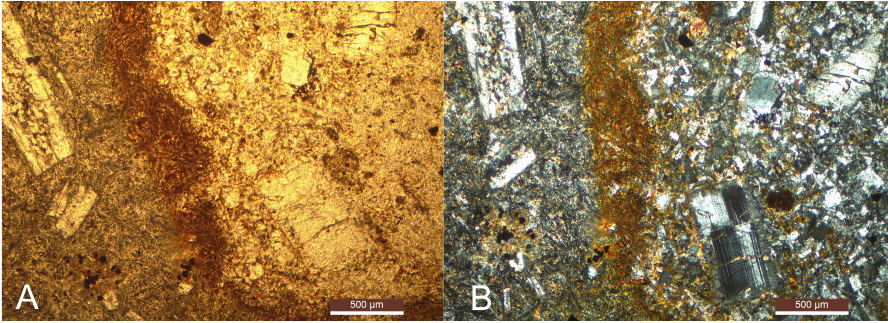
Figure 3. Photomicrograph showing typical appearance of a enclaves-host contact, see text for description. ( A ) parallel polarised light ( B ) cross-polarised